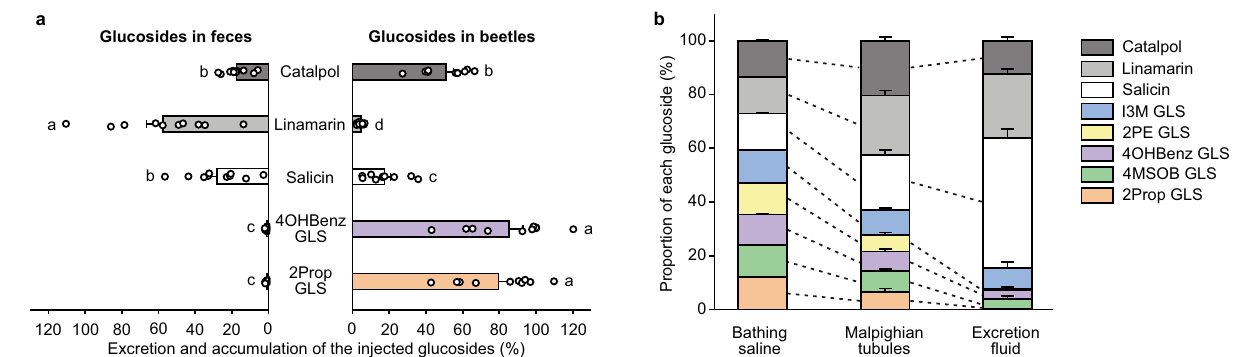
Fig. 3 Selective excretion of plant glucosides in vivo and in situ. a Excretion and accumulation of plant glucosides injected in beetles. Each beetle was injected with 100 nL of an equimolar mixture of fi ve glucosides. Beetles were sampled 30 min after the injection and after 1 day feeding on Arabidopsis ( n = 10 biological replicates, fi ve beetles per replicate). Glucoside excretion was analyzed by quantifying the amount of excreted glucosides in the feces ( n = 10 biological replicates, feces of fi ve beetles per replicate). Glucoside content in beetles and feces is expressed relative to the glucoside amounts detected in beetles 30 min after injection (set to 100%). The relative accumulation and excretion of glucosides were compared using the method of generalized least squares, respectively. Bars labeled with different letters are signi fi cantly different ( P < 0.05). b Excretion of plant glucosides by isolated Malpighian tubules (Ramsay assay). The dissected Malpighian tubule was placed in a droplet of saline and a mixture of eight different plant glucosides each at a concentration of 6.7 mM. To visualize excretion, we added 0.1% (w/v) amaranth. After 2 – 3 h, bathing saline, Malpighian tubule, and excretion fl uid were sampled, extracted, and analyzed by LC-MS/MS. Paired two-tailed Student ’ s t tests were used to compare the relative composition of plant glucosides in bathing saline and Malpighian tubule, and Malpighian tubule and excretion fl uid, respectively. Dashed lines indicate signi fi cant differences between samples (FDR-corrected P < 0.05, n = 11 biological replicates, one dissected tubule per replicate). Data are shown as mean ± s.e.m. P values are provided in Supplementary Data